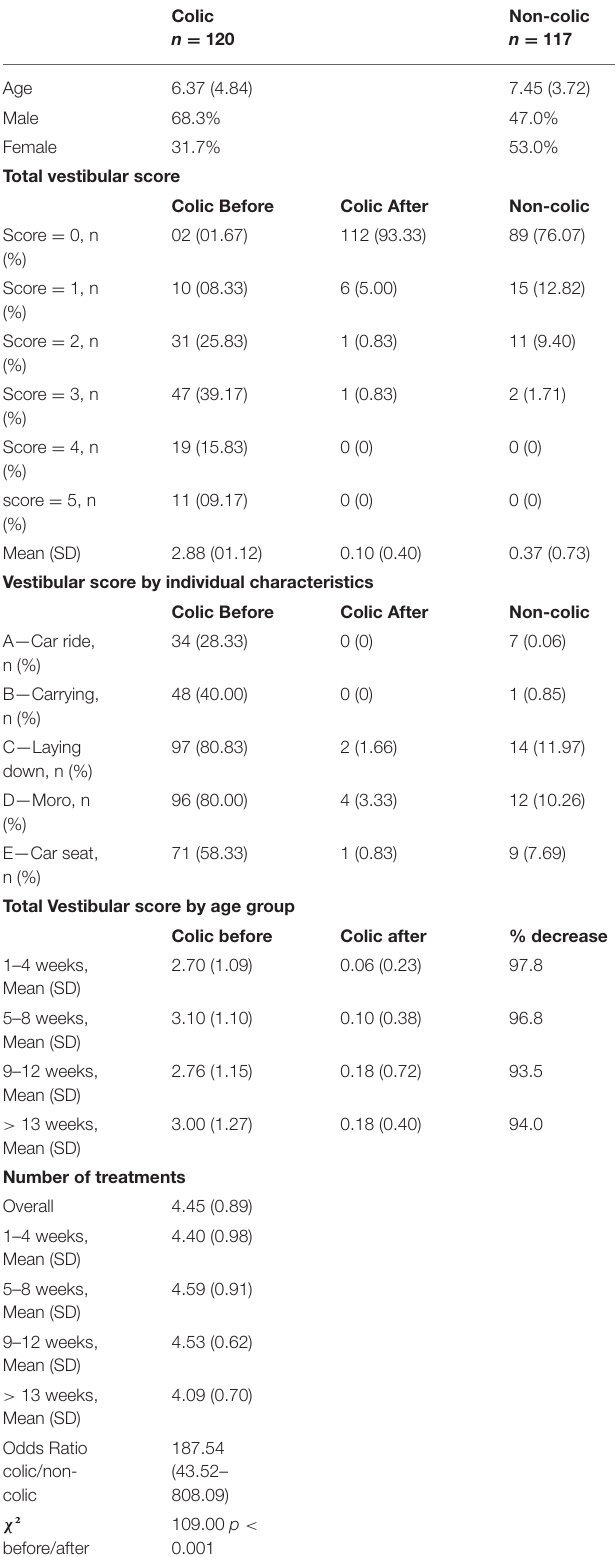
TABLE 1 | Characteristics colicky vs. non-colicky